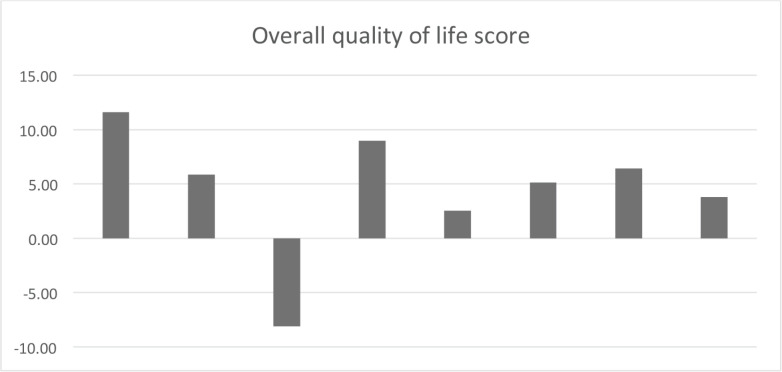
Baseline versus end-of-treatment variation of the overall quality of life score. The majority of patients had an improvement in quality of life at the moment of response evaluation (>5 points). EORTC QLC-30.